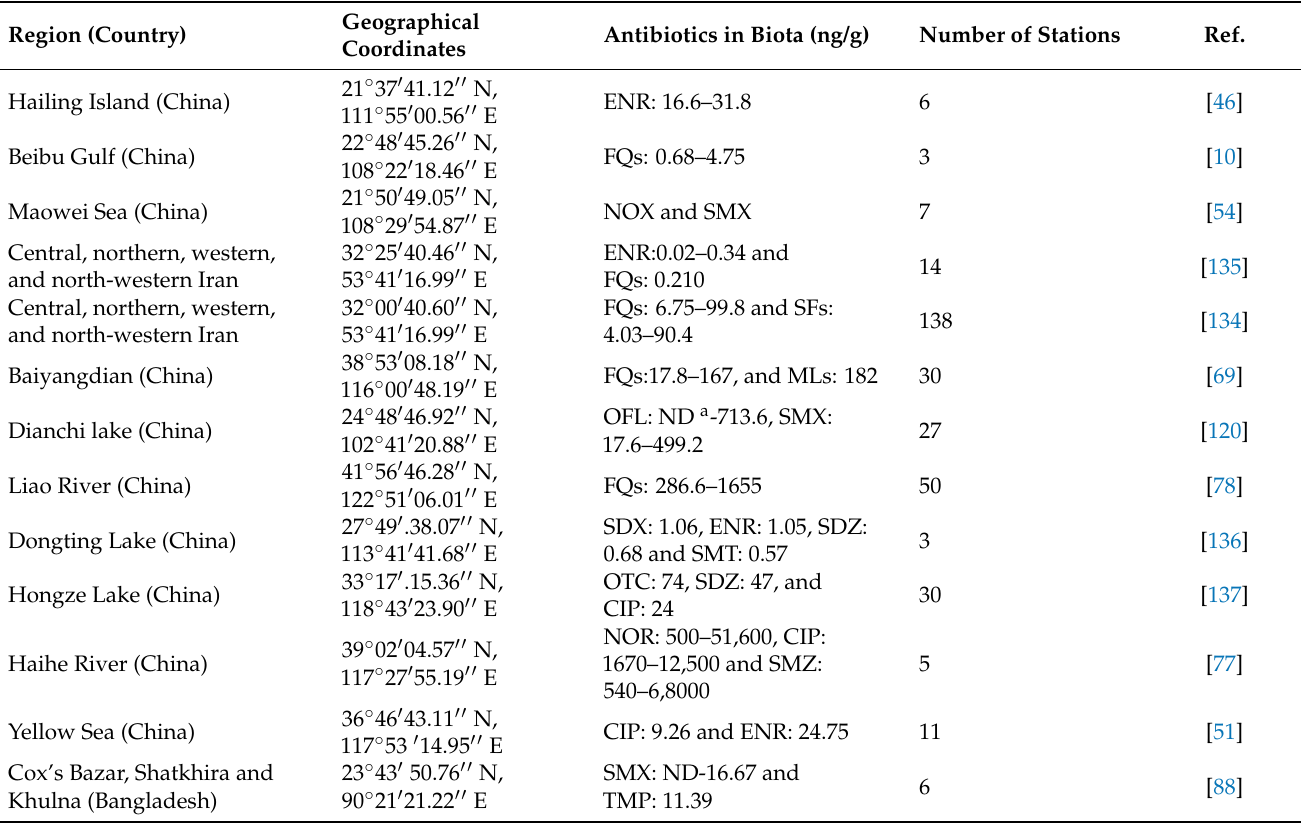
Table 5. Antibiotics reported in biota around the